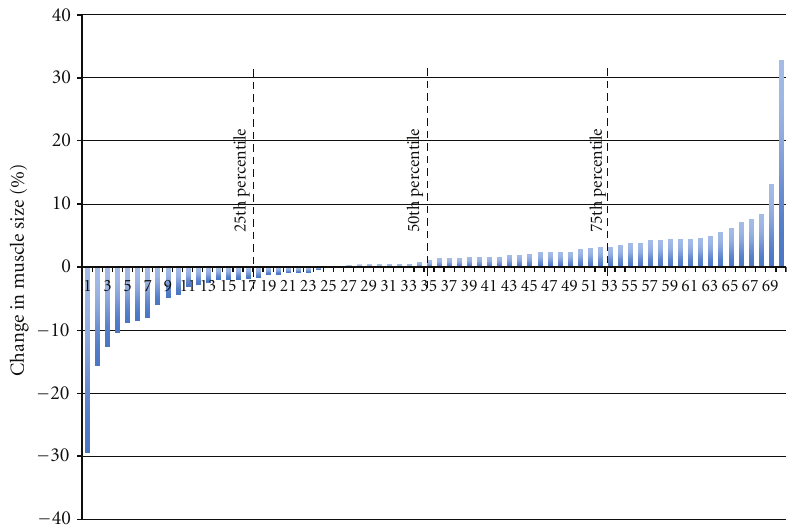
Figure 1: Individual percentage and quartiles of muscle change following 12 weeks of a multicomponent resistance exercise training program in mobility impaired older adults ( N = 70, older (age 73 ±